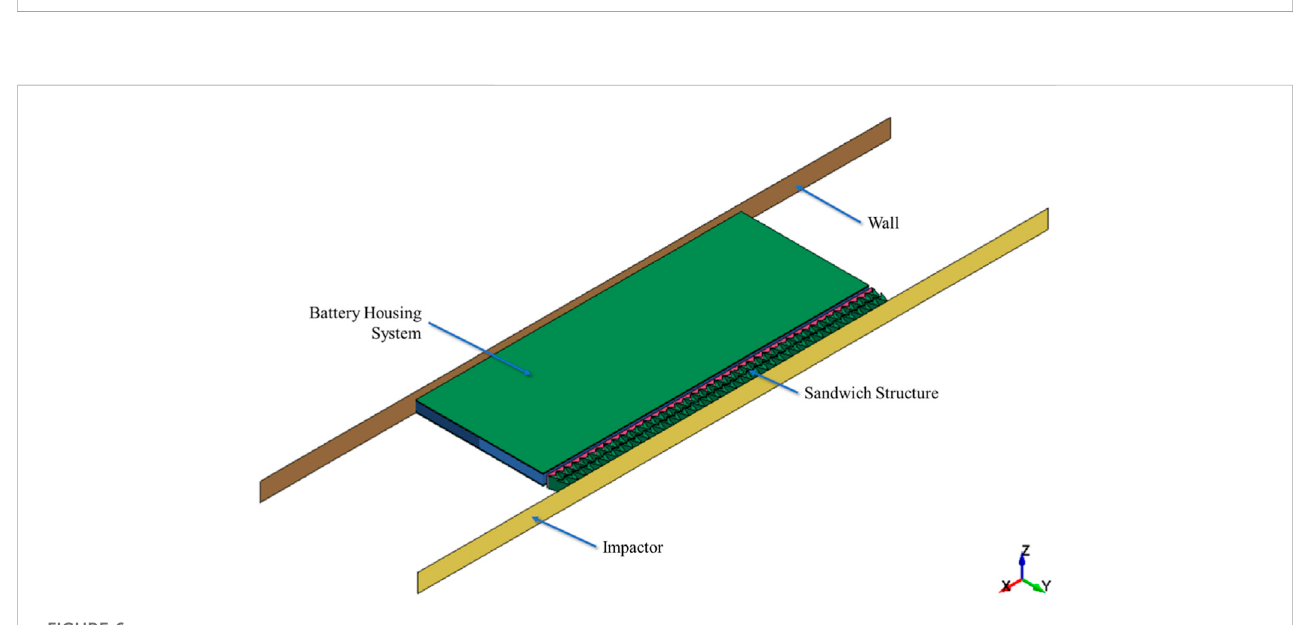
General con fi guration of the system model.